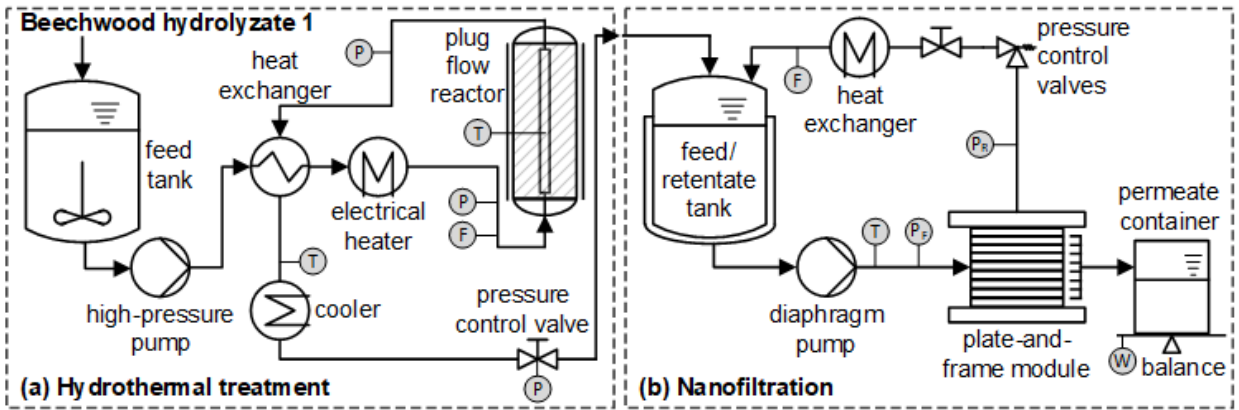
Figure 2. Schematic diagram of the experimental setup for ( a ) hydrothermal treatment and ( b ) nanofiltration .